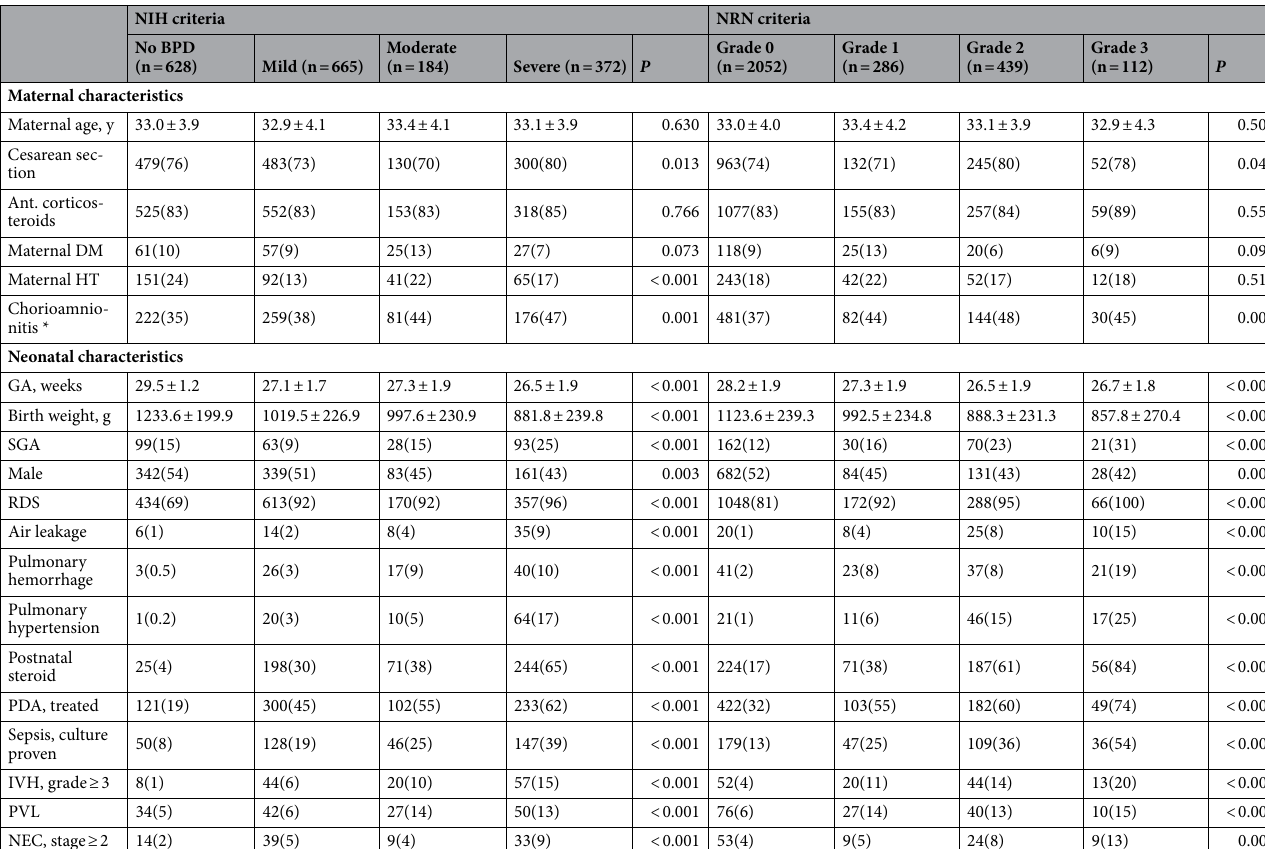
Table 1. Demographic and baseline characteristics and outcomes of VLBWIs according to different respiratory support approaches (n = 1849). NIH National Institute of Health, NRN Neonatal Research Network,